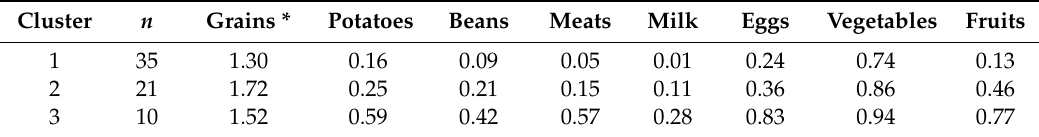
Table 3. The average consumption score for all 8 food items.